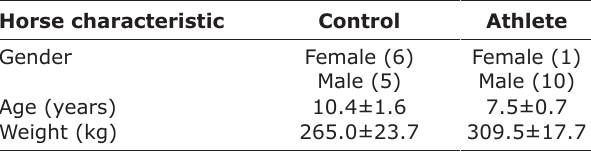
Table-1: Characteristics of horses.